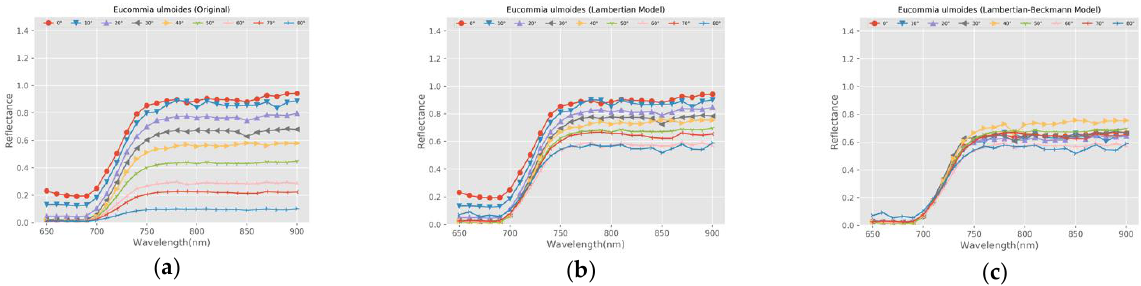
Figure 11. The reflectance comparison of Eucommia ulmoides. ( a ) Before calibration; ( b ) Calibration results of Lambertian model; ( c ) Calibration results of Lambertian – Beckmann model .